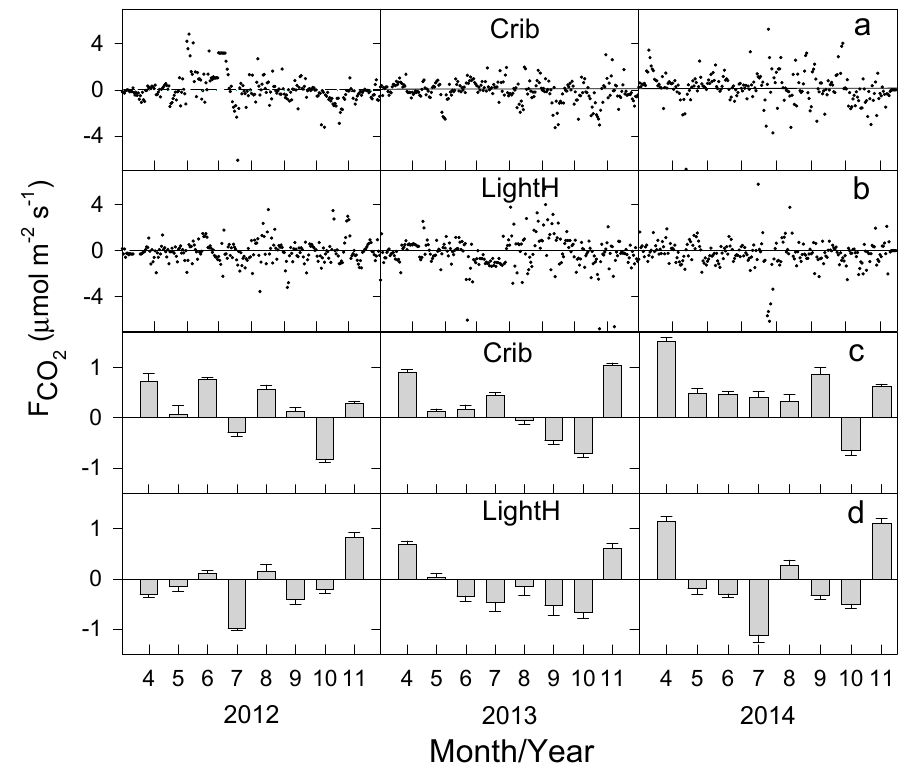
Figure 4. The daily average F CO2 at the Crib (CB) ( a ) and LightH sites; ( b ) in 2012–2014; and the monthly average F CO2 at the Crib; ( c ) and at the LightH sites ;( d ) in 2012–2014.